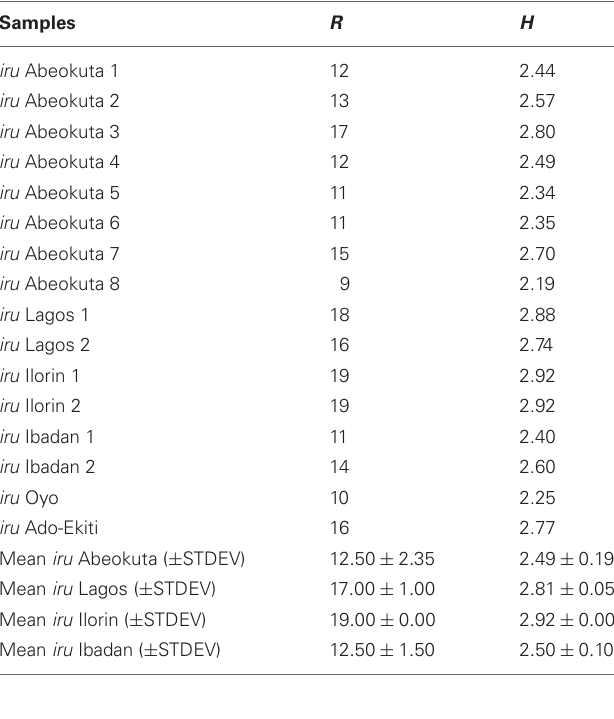
Table 2 | Species richness estimates ( R ) and Shannon’s index of diversity ( H ) of DGGE profiles of fermented iru samples obtained from various geographical locations in Nigeria.